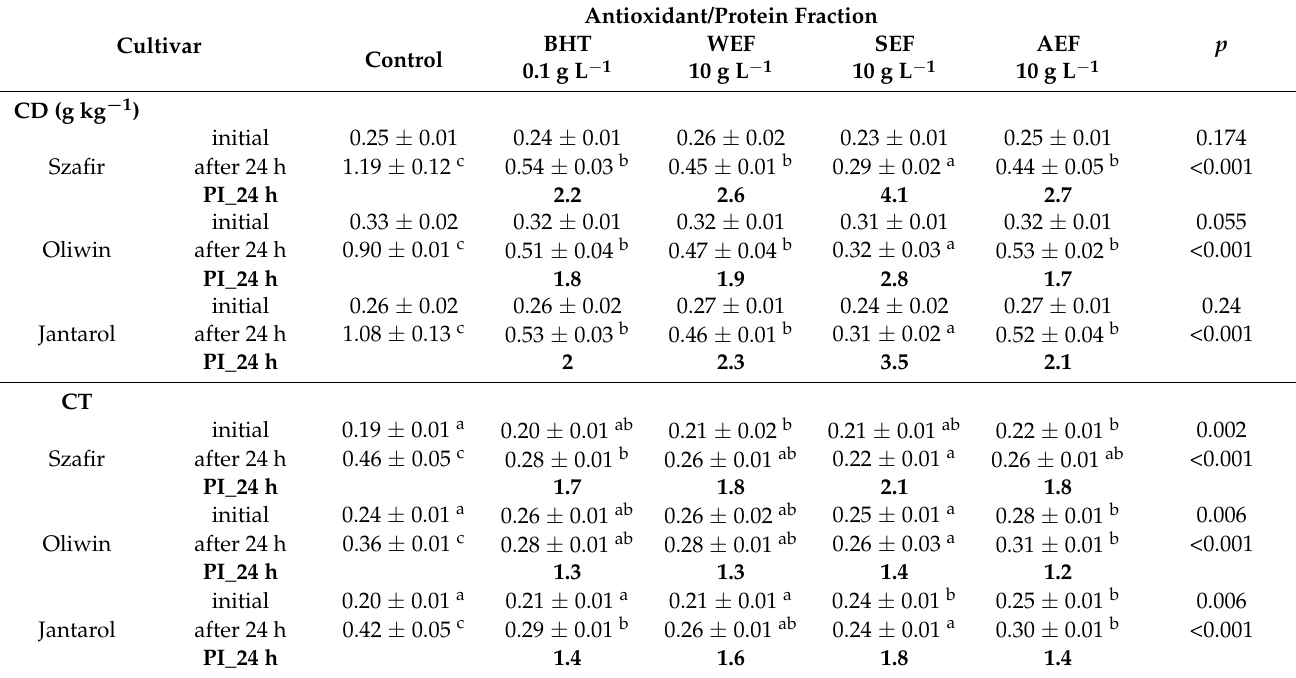
Table 4. Protective effect of the flaxseed protein fractions against oxidation in emulsion